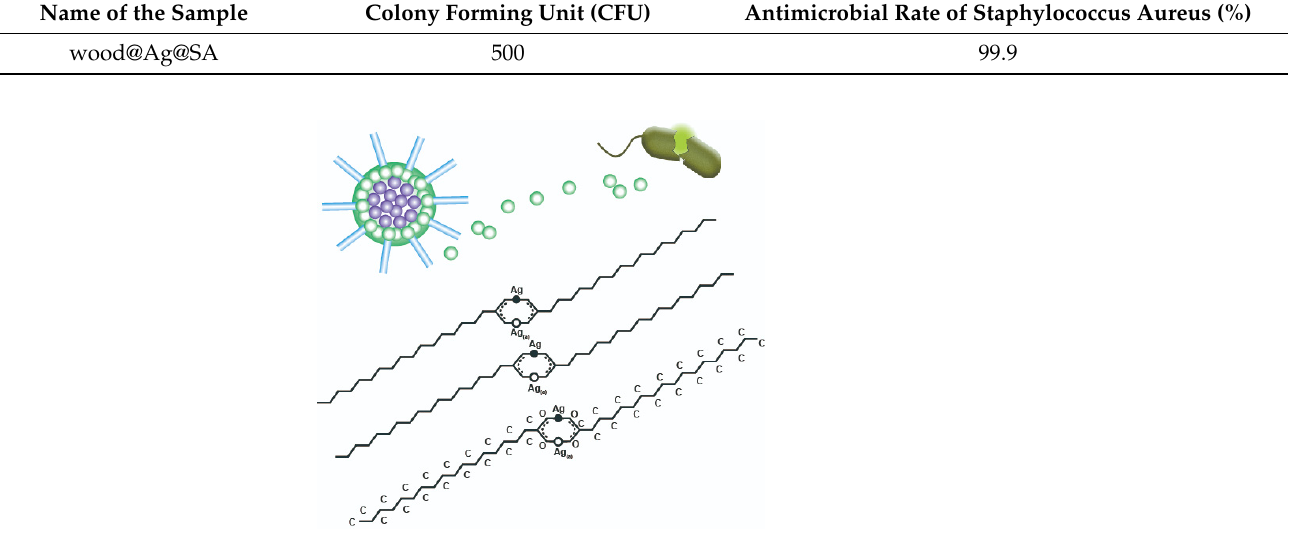
Figure 5. The antimicrobial mechanism of